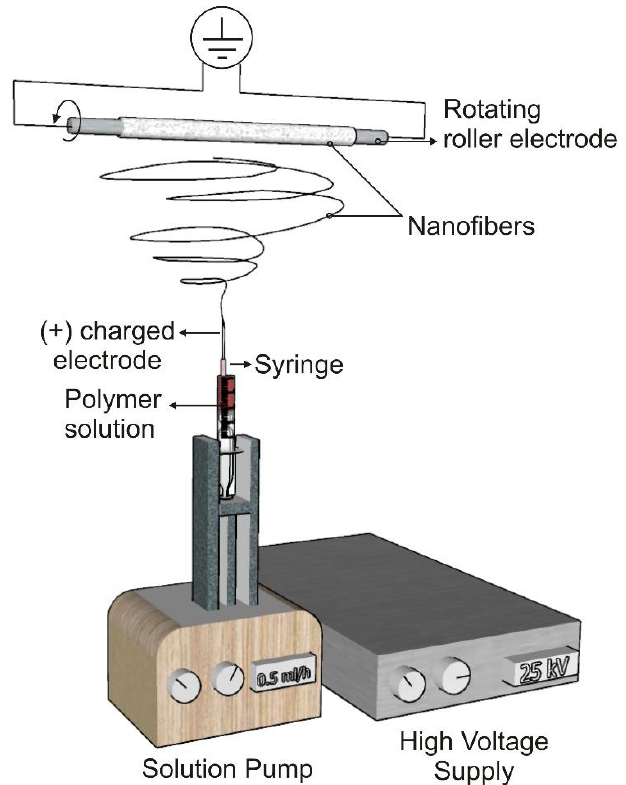
Figure 2. Electrospinning